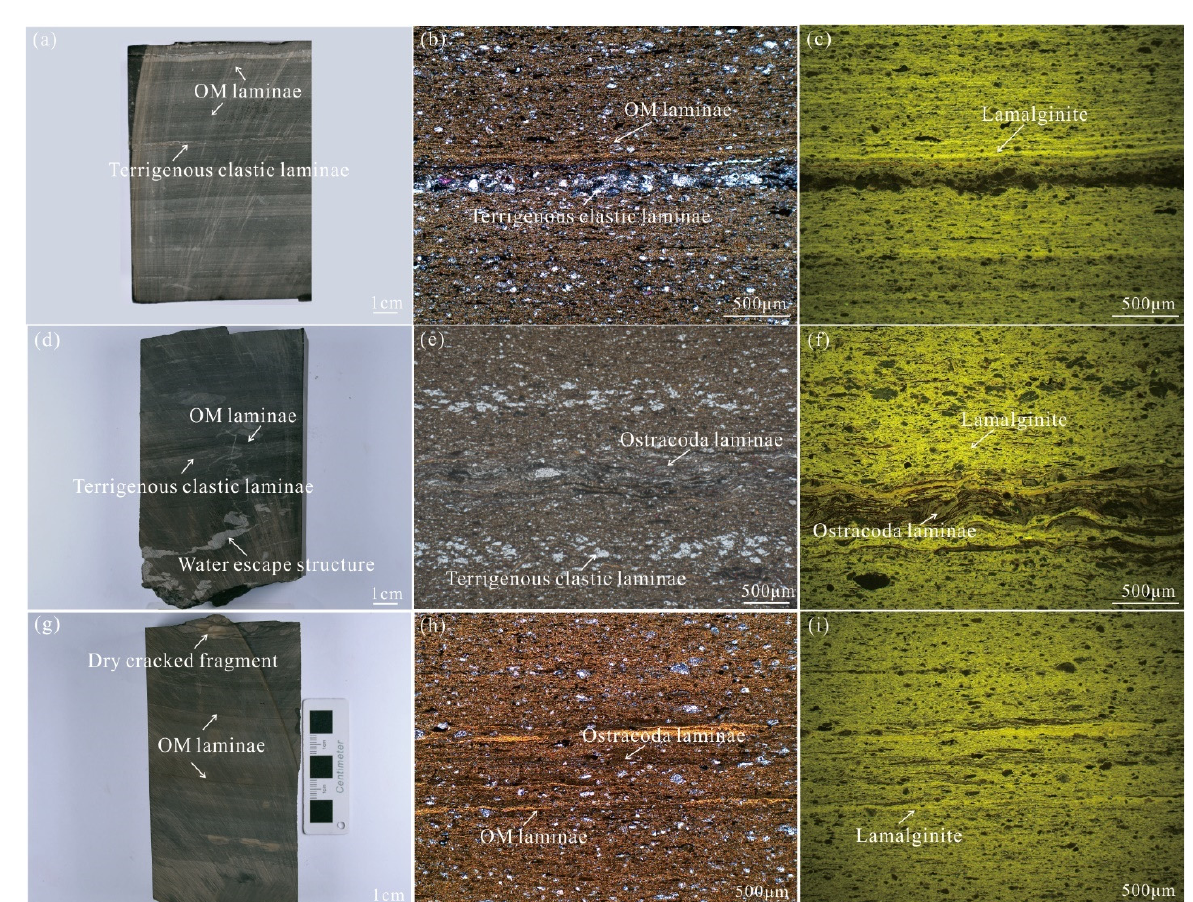
Figure 2. Core images (left), thin sections (middle), and fluorescent photographs (right) of the representative Lucaogou source rocks. ( a , b ) Organic matter (OM) laminae intermingled with terrigenous clastic laminae, mudstone, 3530.8 m. ( c ) Lamalginite displaying yellowish to green fluorescence, 3530.8 m. ( d ) OM laminae, terrigenous clastic laminae, and water-escape structure, dolomitic mudstone, 3576.6 m. ( e ) Ostracoda laminae and terrigenous clastic laminae, 3576.6 m. ( f ) Lamalginite and ostracoda laminae, 3576.6 m. ( g ) OM laminae and dry-cracked fragments, dolomitic mud- stone, 3595.4 m. ( h ) Ostracoda, and OM laminae, 3595.4 m. ( i ) Lamalginite, yellowish to green fluorescence, 3595.4